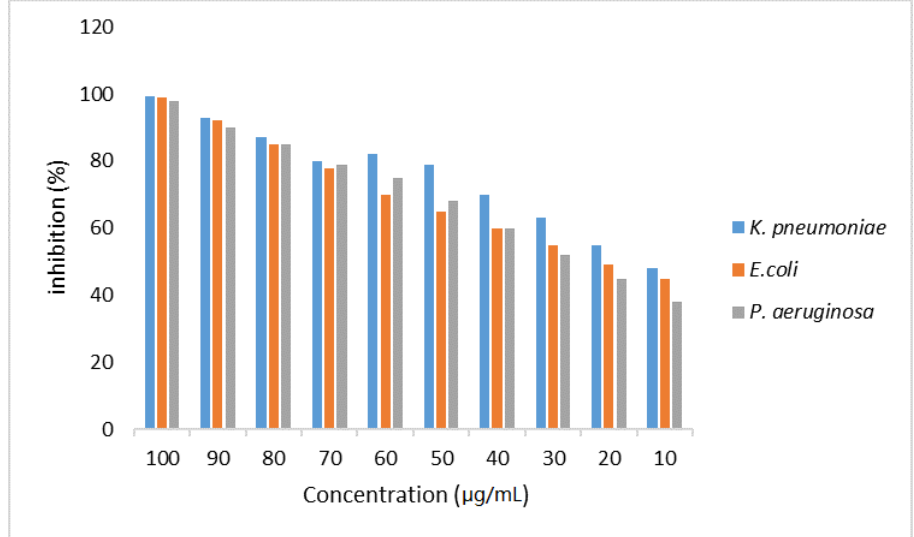
Figure 5. The percent of bacterial growth inhibition of WCSNPs against positive K. pneumoniae , E coli , and P. aeruginosa at concentrations from 10 μg/mL to 100 μg/mL. After 24 h incubation, the maximum growth inhibitions of K. pneumoniae , E. coli , and P. aeruginosa were found to be 99.4%, 98.9%, and 97.8% at 100 µ g/mL, respectively. On the other hand, the inhibition percentages were 48%, 45%, and 38% against K. pneumoniae , E. coli